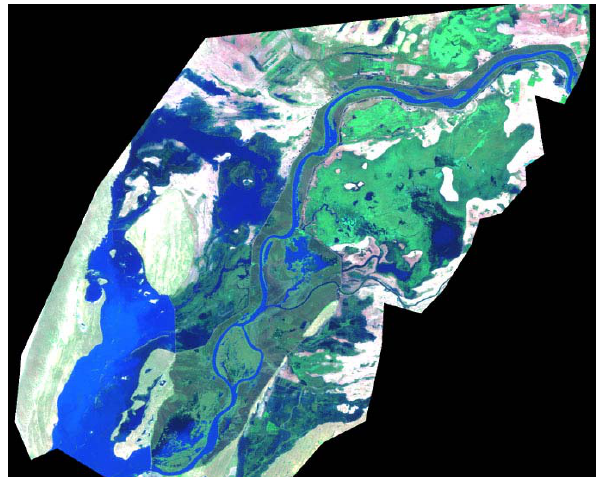
Figure 6: False color image of the 1999 Landsat ETM+ image of the irrigated and forest areas in the Upper Senegal Basin displayed as RGB 742 Spatial Analysis of